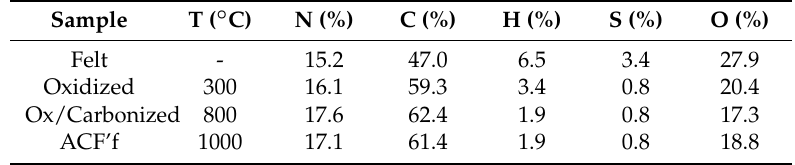
Table 1. Elemental analysis of the material at every stage of the treatment (mass percentages). Sample T ( ◦